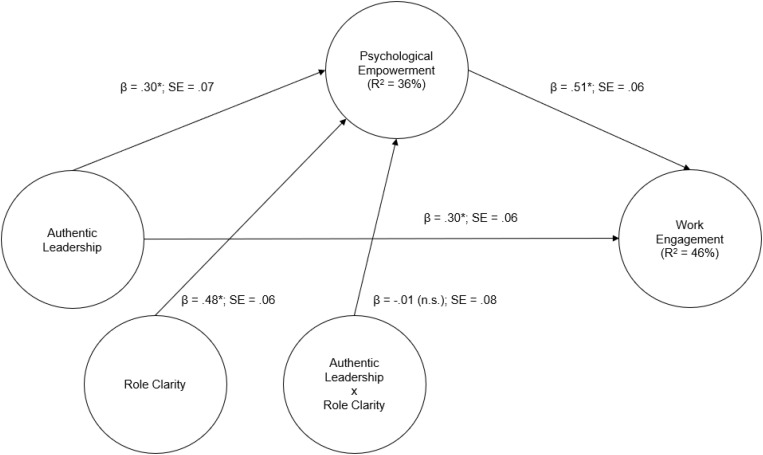
Results for the hypothesized moderated-mediation model.